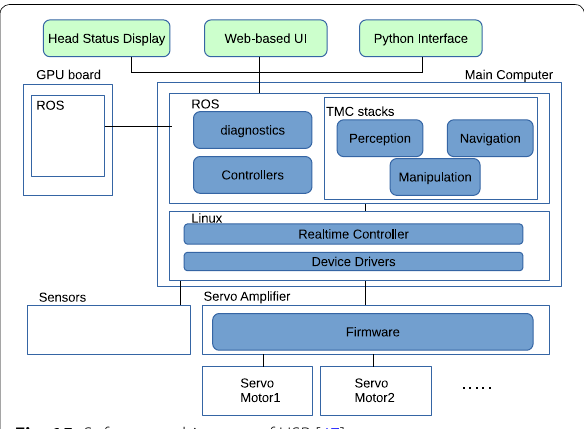
Fig. 15 Software architecture of HSR